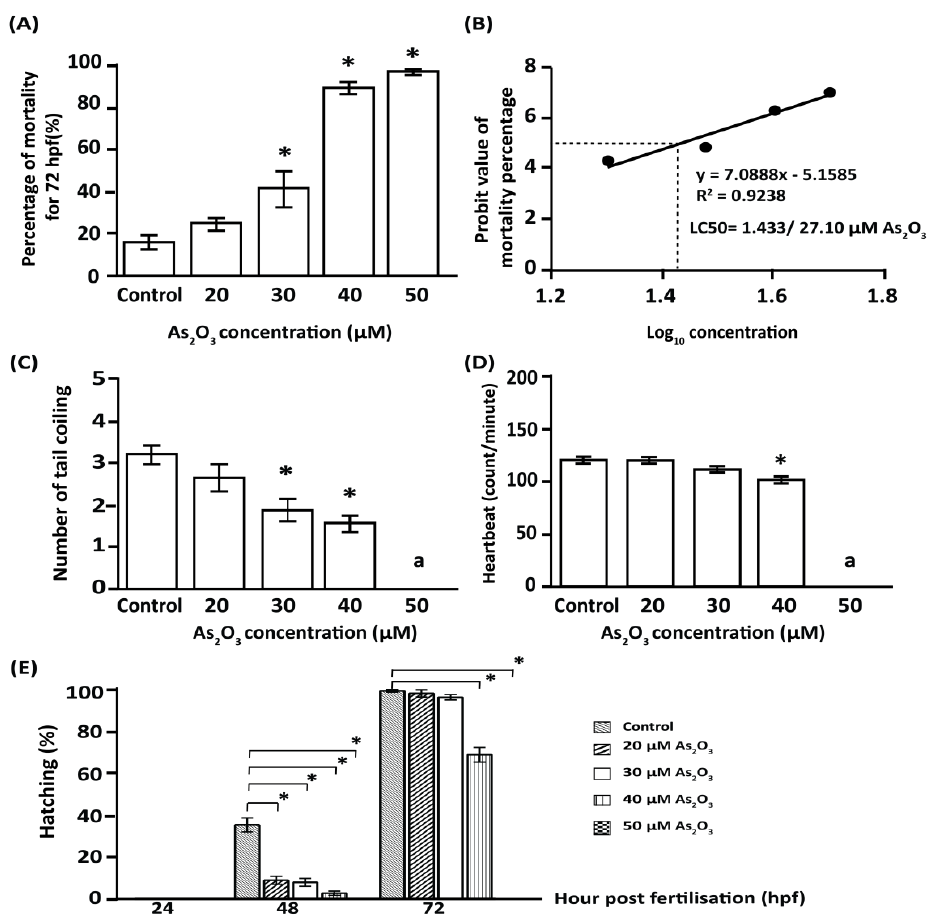
no tail coiling occurred in embryos exposed to 50 µ M As 2 O 3 , as all embryos were dead after 24 hpf.